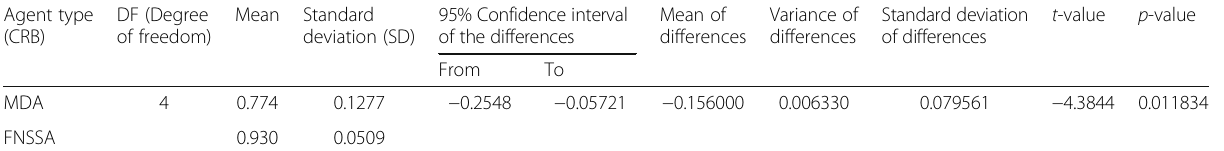
Table 11 Significant results of t-test statistical method for financial utility metric in marketplaces which are made based on Market_SS1